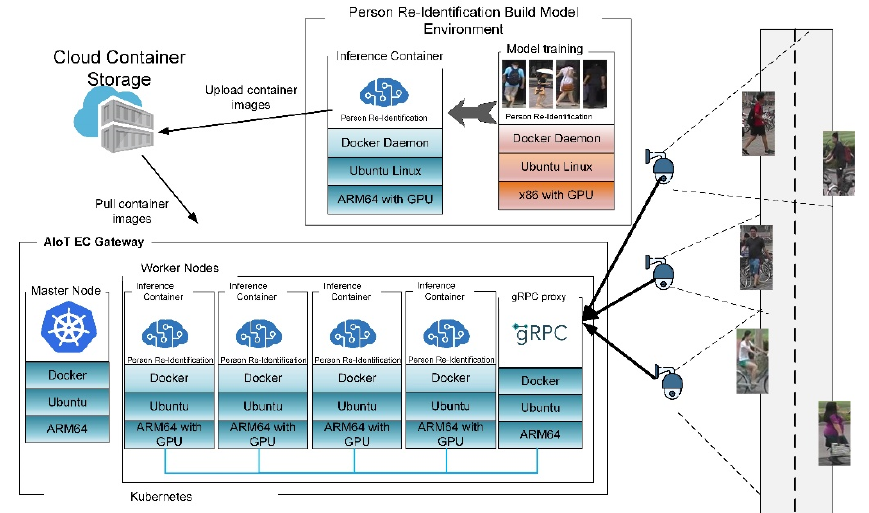
Figure 7. AIoT EC gateway development and experiment environment.